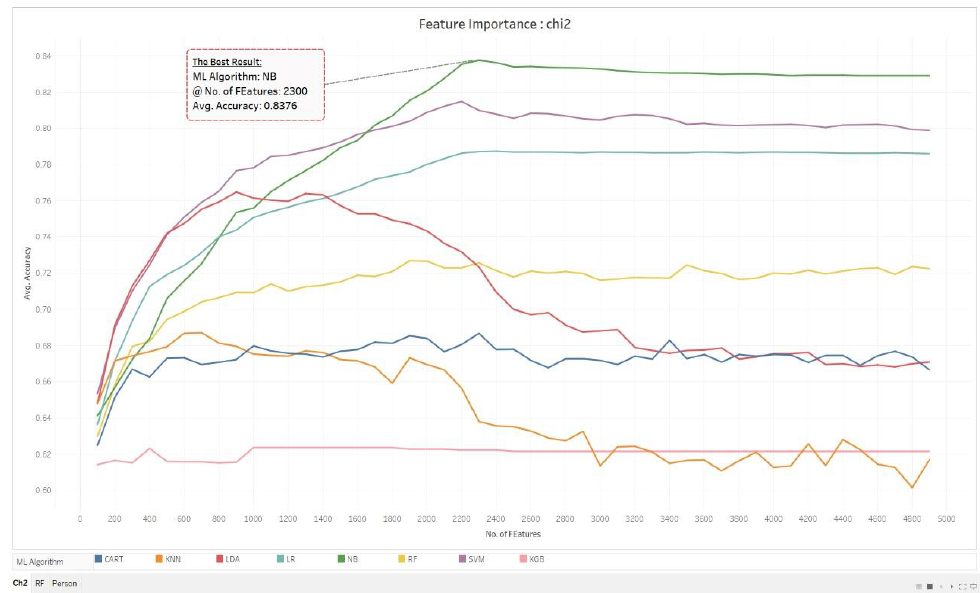
Figure 5. Accuracy of Chi 2 feature selection method with ML models .